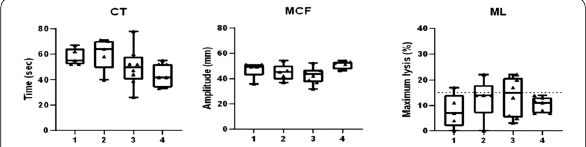
Fig. 1. Rotational thromboelastometry (ROTEM), EXTEM results. Data are represented as median with IQR. 1) Control. 2) Trauma only.